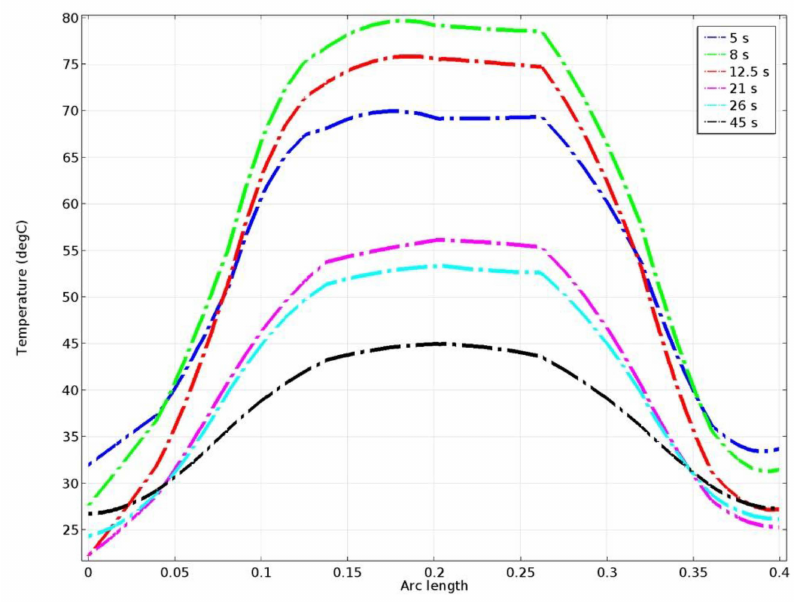
Figure 10. Temperatures along the Cut Line 3D data set, at certain moments of